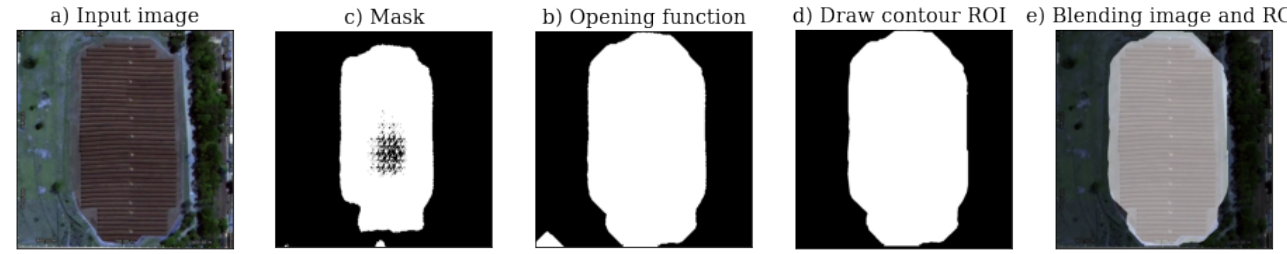
Figure 6. Steps of boundary extraction by the DL server and OpenCV functions in the Unioeste 1 PV plant.